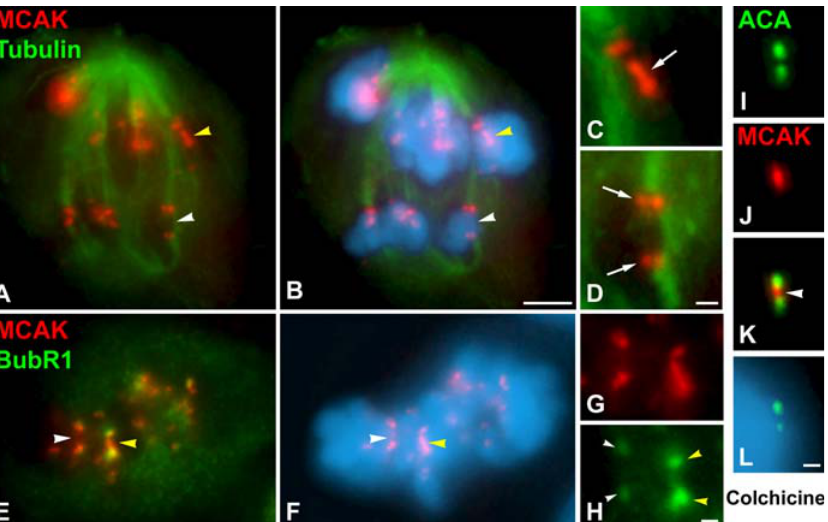
Figure 5. MCAK Reorganisation at Metaphase II Centromeres Depends on MT Attachment or Tension across the Centromere MCAK is labelled in red, a -tubulin (A–D), BubR1 (E–H), and kinetochores (I–L) in green, and DNA in blue. (A and B) Prometaphase II. MCAK appears either as a band that traverses the centromere (yellow arrowhead) when they are not associated with bundles of kMTs, or as two pairs of dots (white arrowhead) when centromeres are associated with bundles of kMTs from opposite poles. (C and D) Enlargements of the centromeres indicated in (A) and (B). Arrow in (C) indicates the band of MCAK, and arrows in (D) the pairs of MCAK signals. (E and F) Prometaphase II. When MCAK appears as a band (yellow arrowhead) BubR1 shows an intense labelling at kinetochores, while when MCAK is observed as pairs of dots (white arrowhead) the BubR1 signals at sister kinetochores are faint. (G and H) Enlargements of the centromeres indicated in (E) and (F). Yellow arrowheads in (H) indicate intense BubR1 signals, and white arrowheads in (H) faint BubR1 signals. (I–L) Selected centromere from a colchicine-treated metaphase II spermatocyte. MCAK appears as a small patch (arrowhead in [K]) in between sister kinetochores. Bars, 2.5 l m (A,B,E,F) and 0.5 l m (C,D,G,H,I–L). DOI: